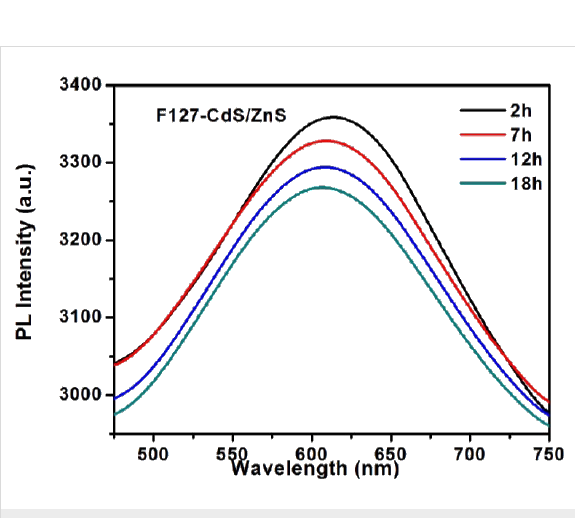
Figure 8: F127-CdS/ZnS PL spectra for photobleaching.